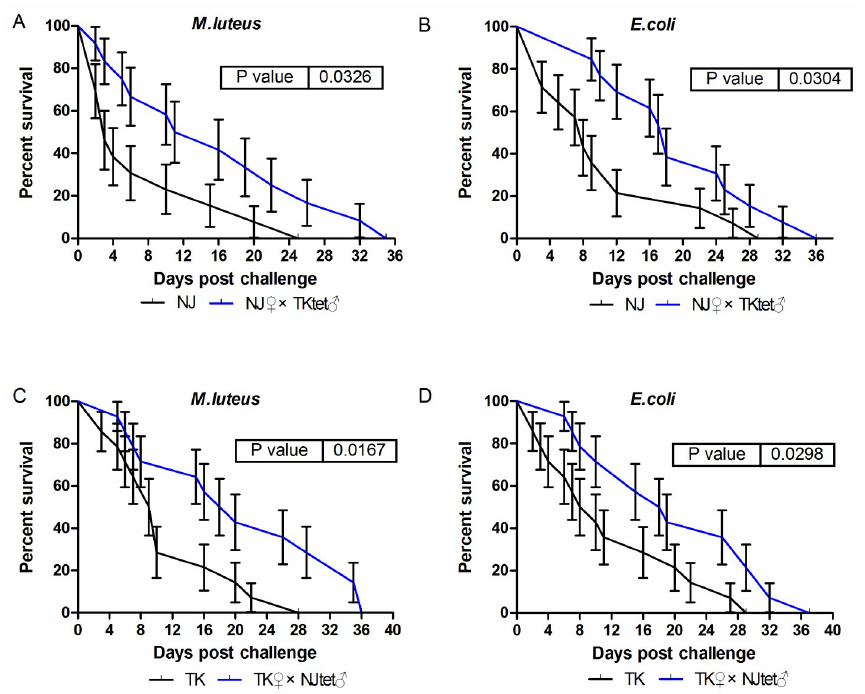
Fig 6. Survival curves of the mosquitoes post-challenge with E . coli (a) or M . luteus (b). For each mosquito population, three parallel groups of 15–20 adult females each were inoculated per bacterial species. A total of three biological replicates of the infection experiment were performed. Error bars indicate the standard error. Survival curves are significantly different between mosquitoes in old and new host- Wolbachia symbioses (compared using log-rank test).